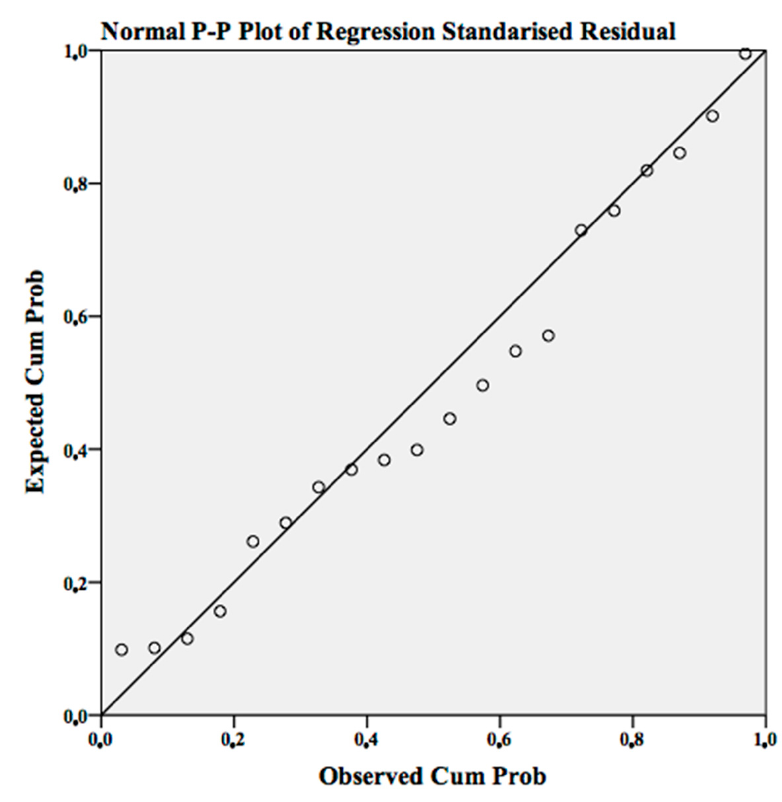
Figure 3. Normal P-P regression graph standardised residue.